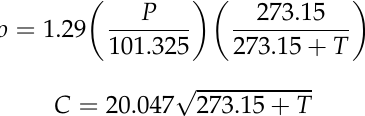
Figure 4. Detail of incident and reflected waves during sound absorption testing.